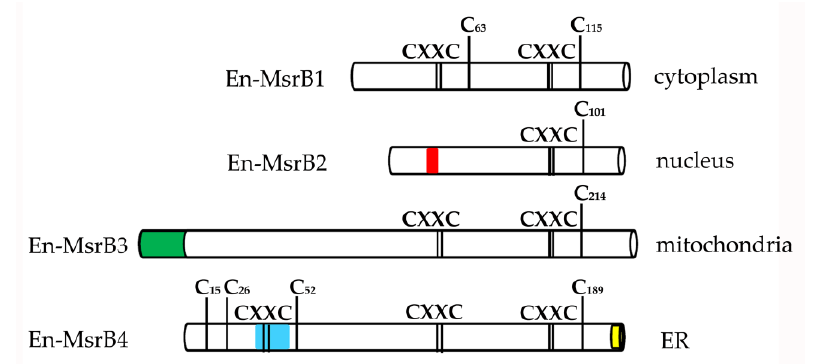
Figure 5. Schematic representation of the En-MsrB protein structure. The positions of the zinc-ion binding CXXC motifs, the catalytic and resolving cysteines, and the additional Cys residues specific of the En-MsrB4 amino-terminal region are indicated by bars. Boxes of different color indicate the relative positions and length of the signals for mitochondrial targeting (green), ER retention (yellow), nuclear localization (red) and trans-membrane domain (blue).